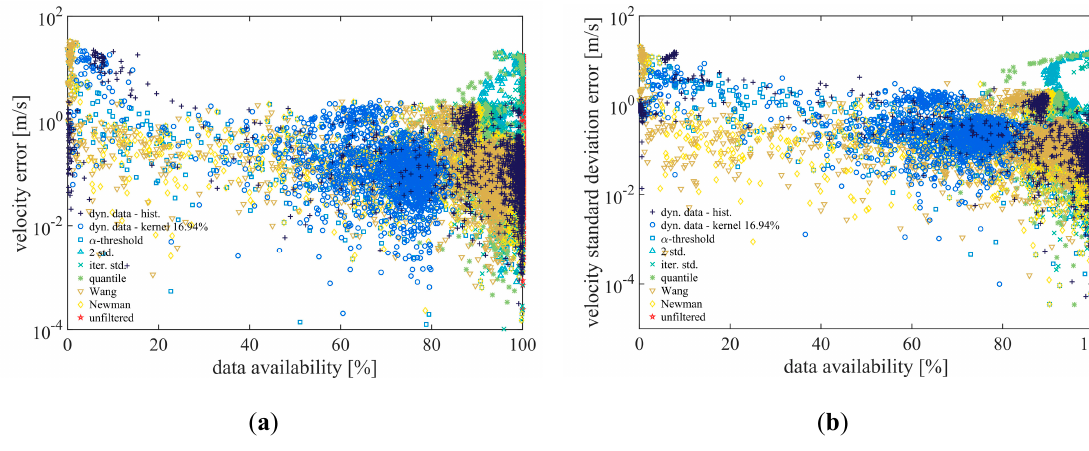
Figure 11. Absolute error of staring mode measurements in dependency of data availability. Markers represent 10 min values of ( a ) the velocity error and ( b ) the velocity standard deviation.